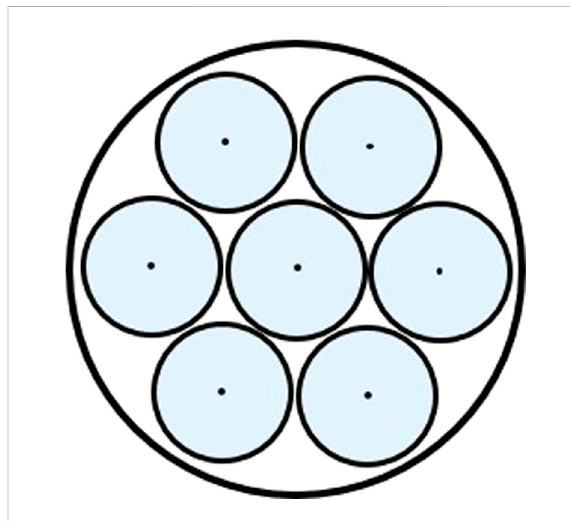
FIGURE 1 Schematic diagram of the structure of cluster-type straw.